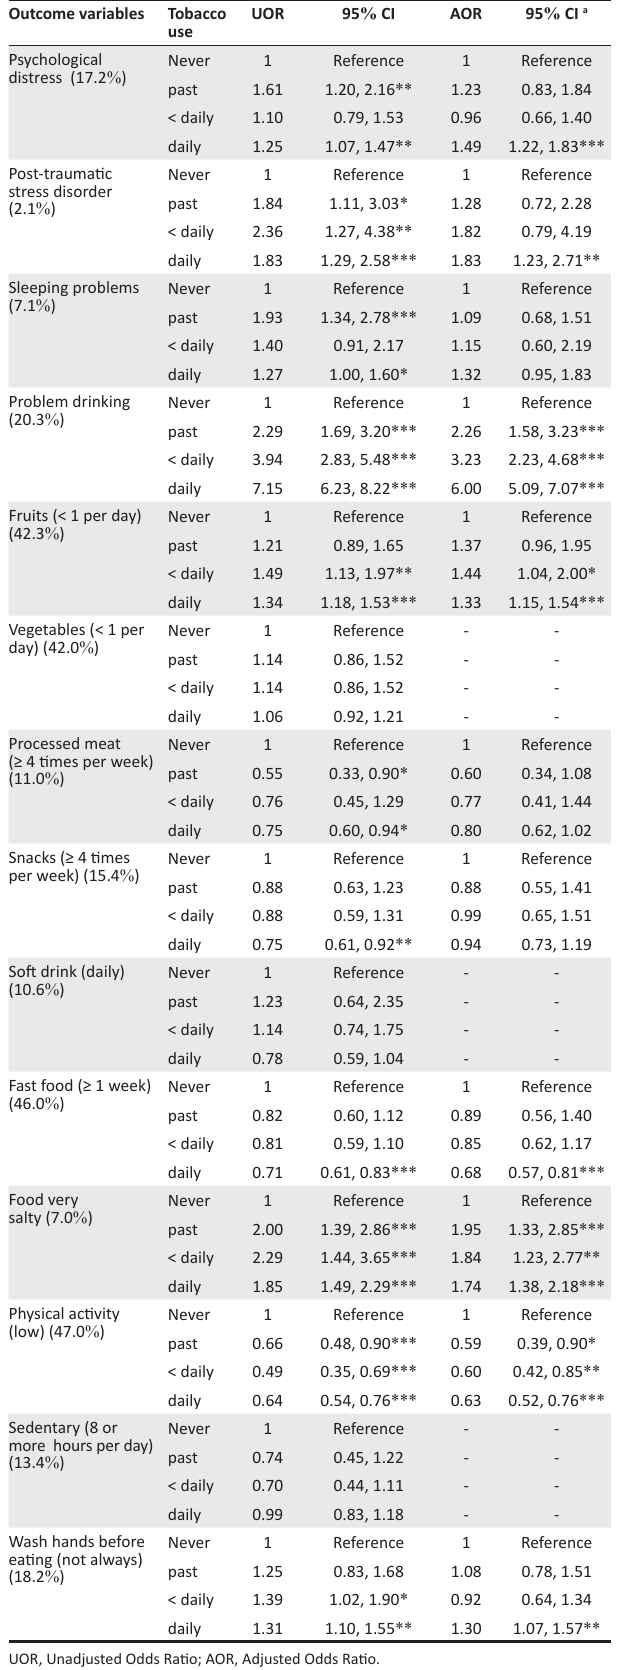
TABLE 1: Associations between tobacco use categories and outcome variables. Outcome variables Tobacco